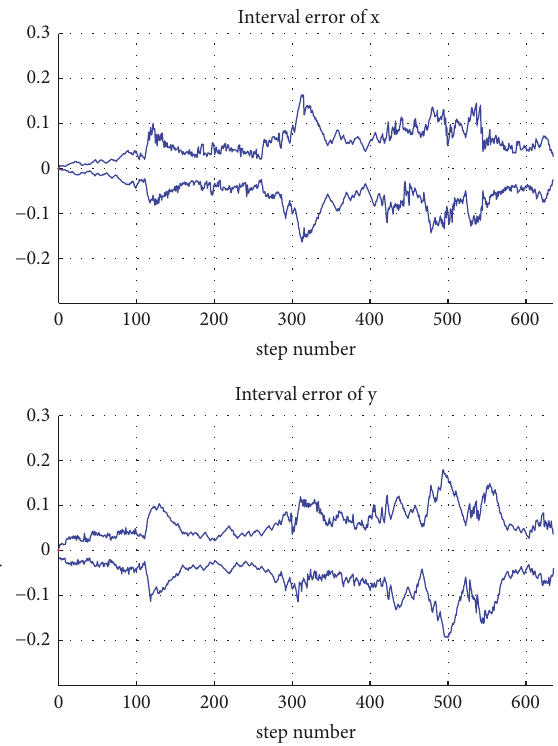
Figure 17: Interval error of real-time localization result.